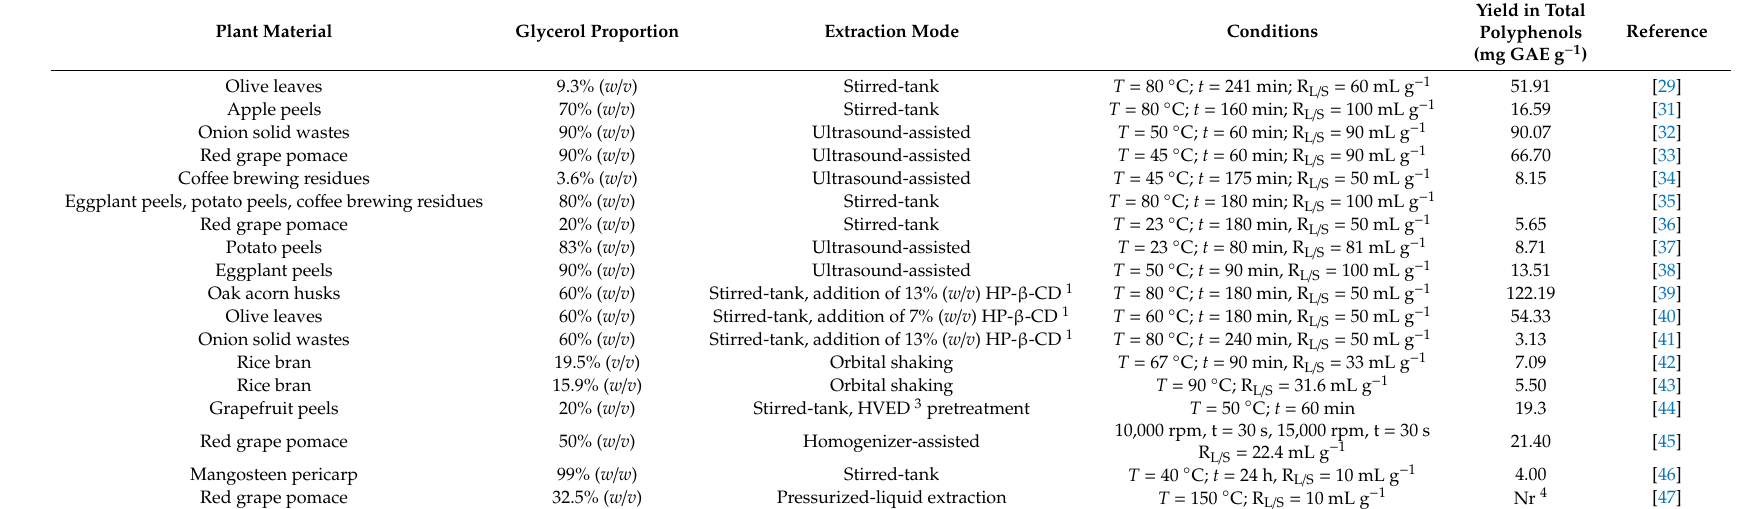
Table 1. Representative examples of total polyphenol recovery from plant food wastes using aqueous glycerol